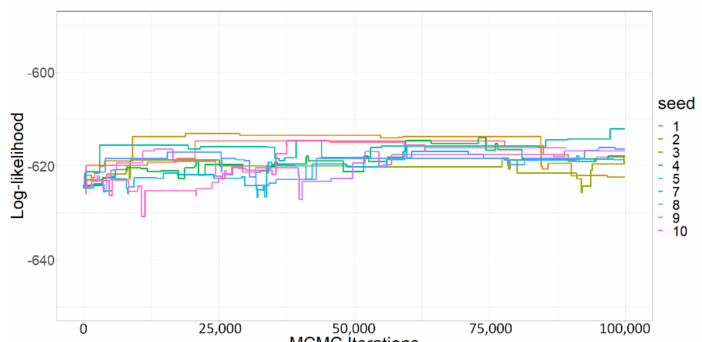
Figure A2. Posterior log-likelihood for iterations of the 10 independent Monte Carlo Markov chains of the third and last session. All chains were initialized with the same parameters obtained from the two previous MCMC sessions.